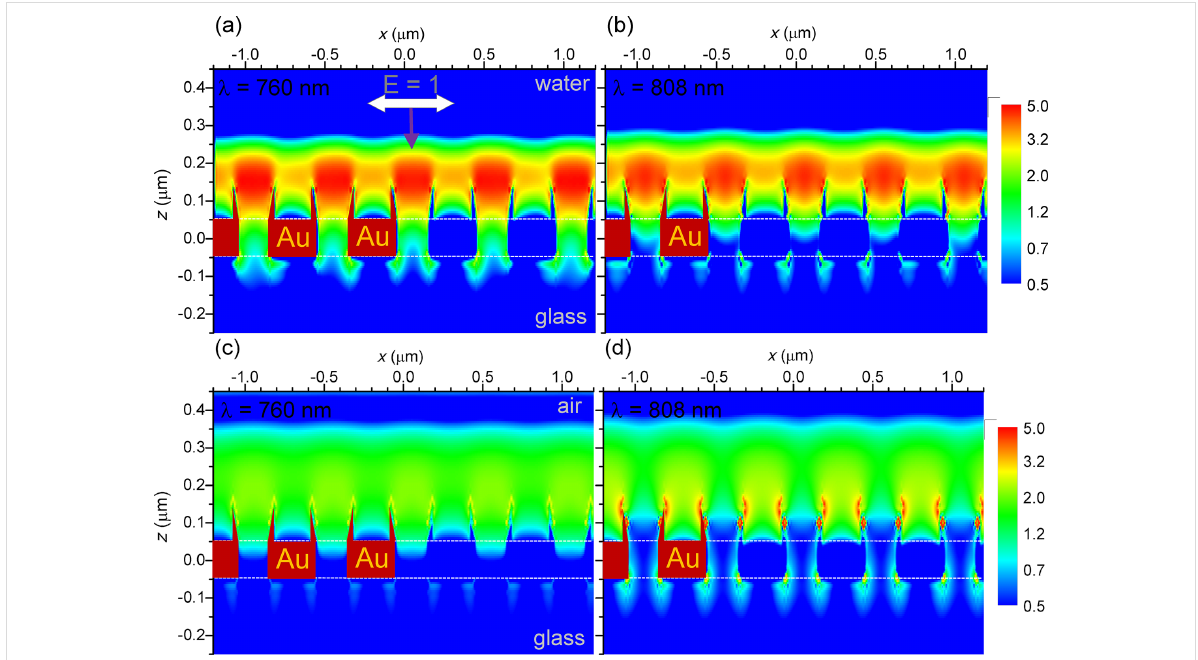
Figure 4: Light intensity distribution in the xz -plane simulated by 3D-FDTD at the two laser wavelengths (a,c) 760 nm and (b,d) 808 nm, in (a,b) water and (c,d) air. Incident light intensity | E 0 | 2 = 1; propagation in negative z -direction.